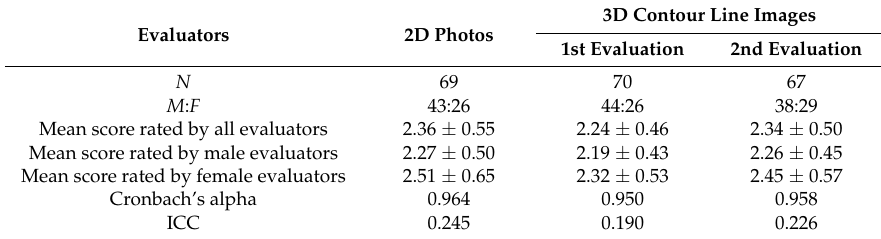
Table 1. Distribution of evaluators’ gender, mean attractiveness scores, Cronbach’s alpha, intraclass correlation coefficient (ICC) and statistics of the differences between the attractiveness scores given by the male and female evaluators.